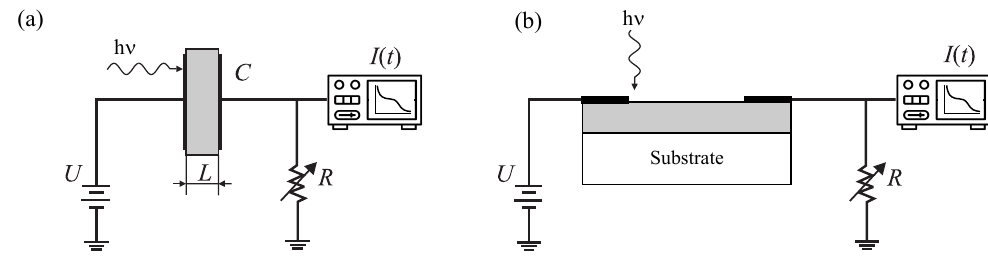
Figure 1. The time-of-flight method in the vertical ( a ) and coplanar ( b )